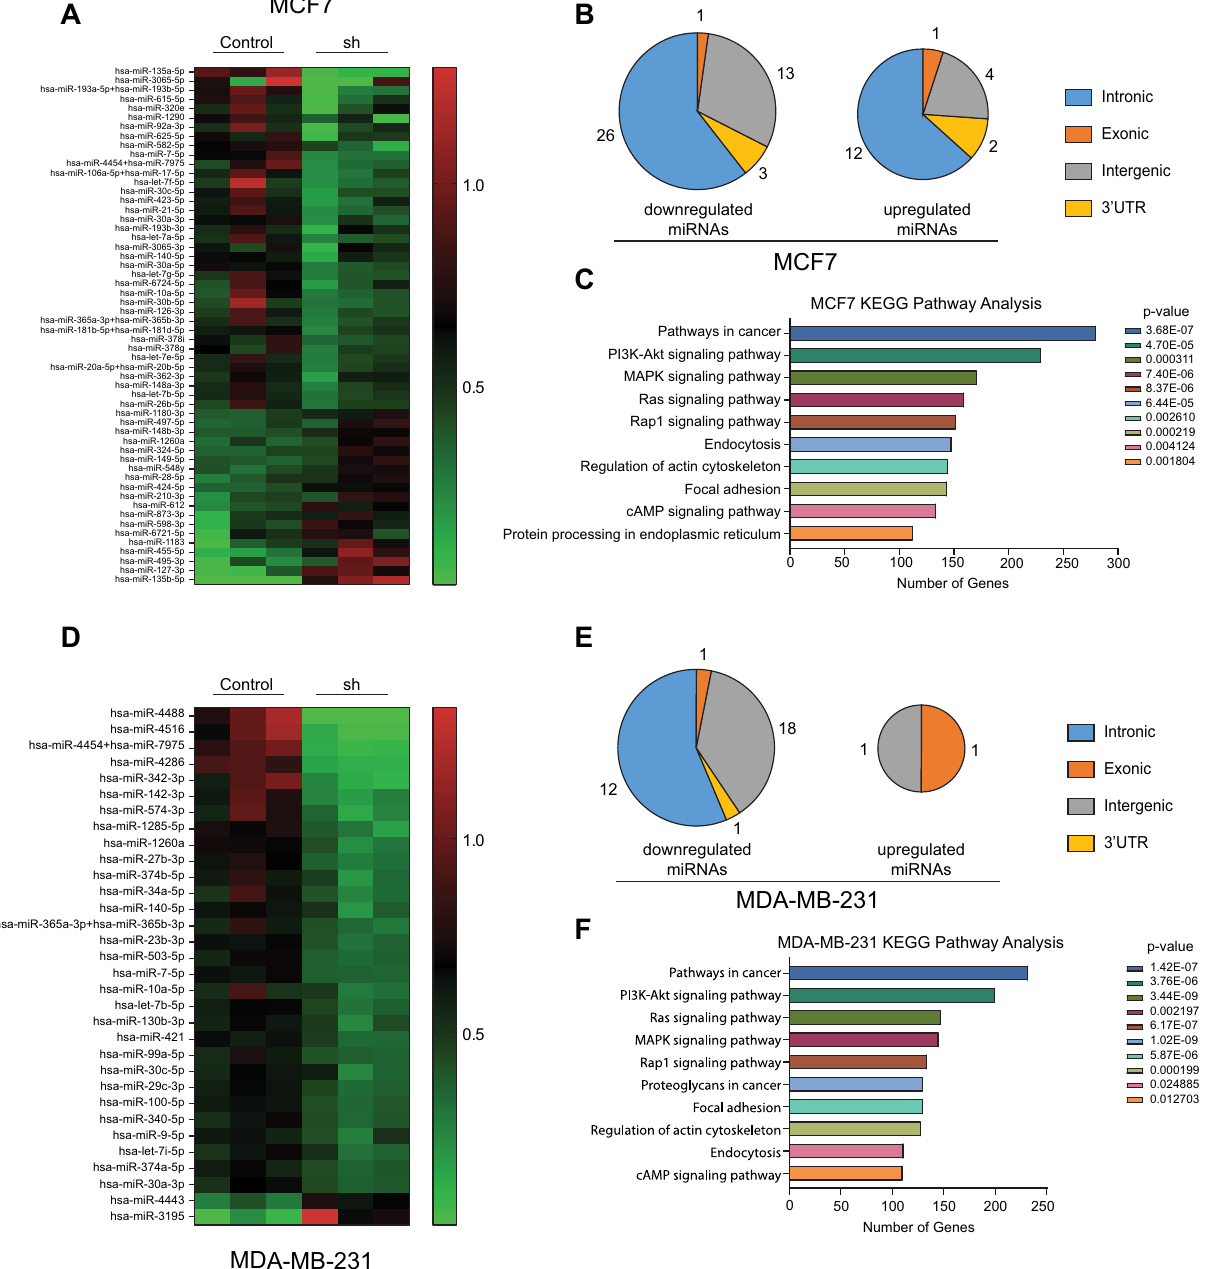
Figure 6. Effect of HNRNPA1 silencing on miRNAs. ( A ) RNA isolated from HNRNPA1 silenced, and control cells were detected by NanoString miRNA panel . Heatmap shows miRNA expression fold changes (< 0.6 and > 1.5) in HNRNPA1sh (A1-sh) MCF7 cells. ( B ) Pie charts visualize the proportion of differentially expressed miRNAs grouped according to their genomic features in HNRNPA1sh (A1-sh) MCF7 cells (blue color for the intronic miRNAs, orange for exonic miRNAs, gray for intergenic, and yellow for miRNAs located in 3’UTRs of host genes). ( C ) Biological pathways affected by miRNAs whose expression levels were changed upon long-term HNRNPA1 silencing in MCF7 were determined by DIANA-mirPath. ( D ) Heatmap shows miRNA expression fold changes (< 0.6 and > 1.5) in A1-sh MDA-MB-231 cells. ( E ) Pie charts visualize the proportion of differentially expressed miRNAs grouped according to their genomic features in HNRNPA1sh (A1-sh) MDA-MB-231 cells. ( F ) Biological pathways affected by HNRNPA1 regulated miRNAs in MDA-MB-231